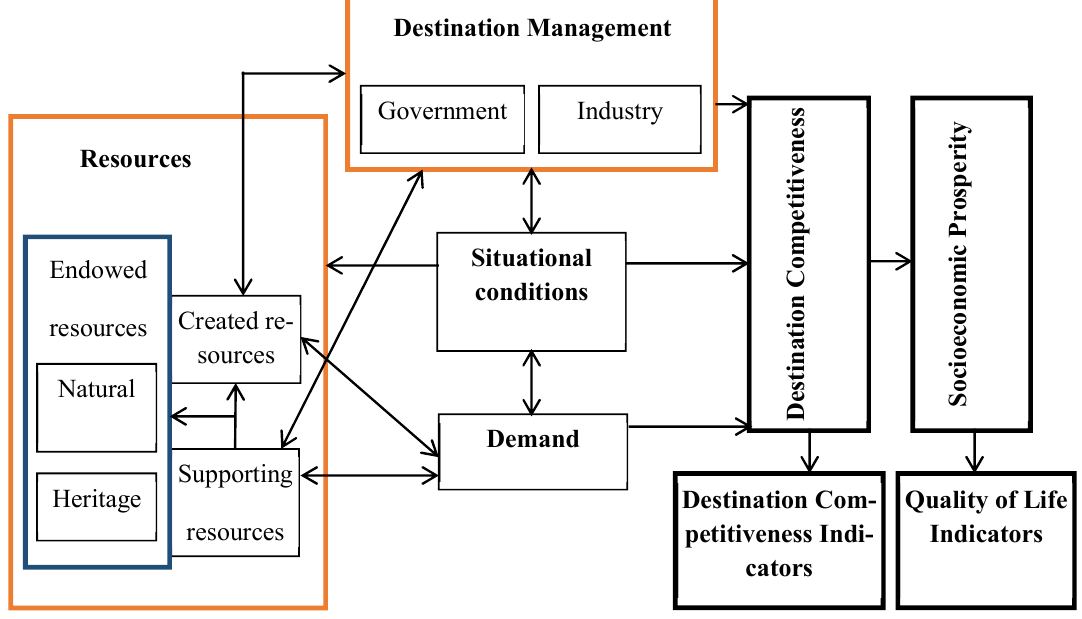
Fig. 1. Competitiveness assessment model for sea and island tourism in Nghe